Question: Generate an informative caption for the figure above.
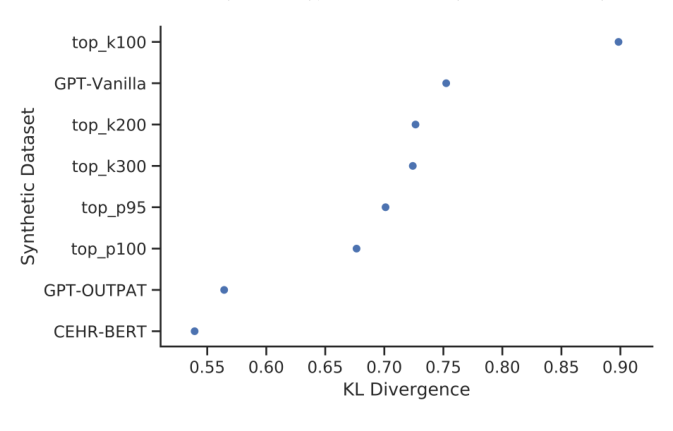
Answer: KL divergence for comparing concept probability dis- tribution between synthetic data and real data. The probabilities of concepts were calculated on the scale of the entire population.